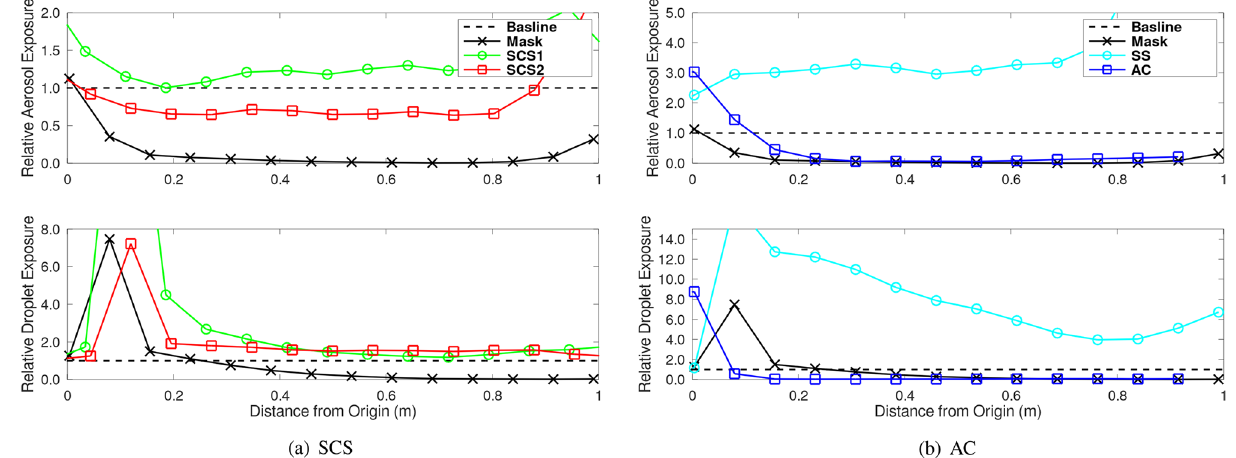
Figure 9. Relative exposure to aerosols (upper subplot) and droplets (lower subplot) as a function of distance using ( a ) SCS and ( b ) AC.